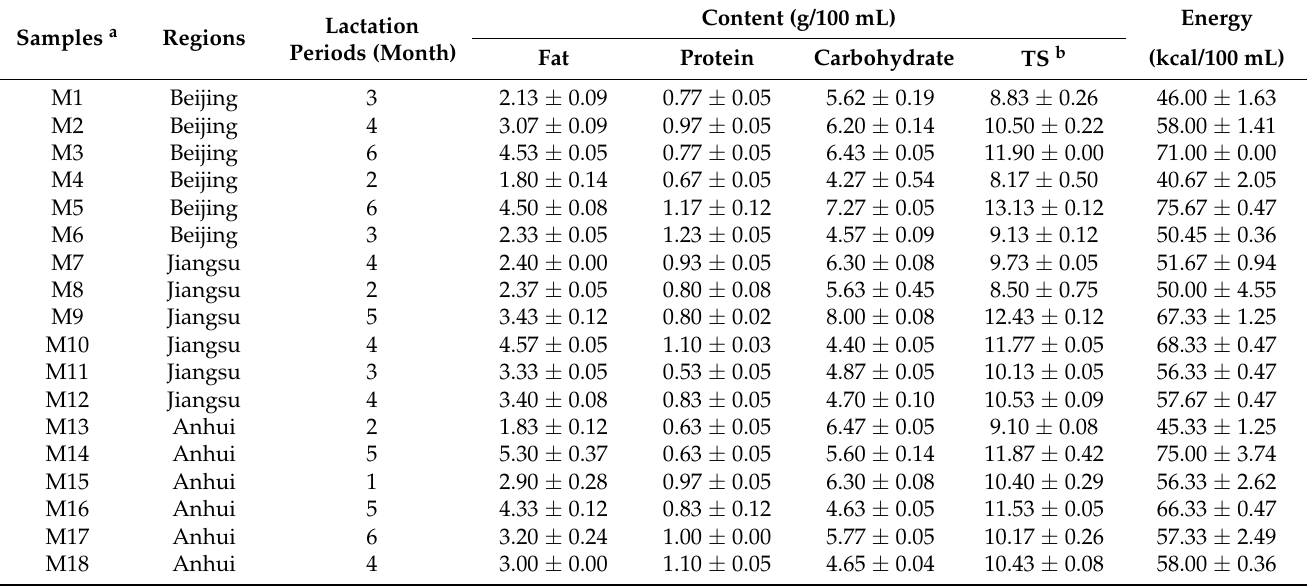
Table 1. The information of 18 human milk